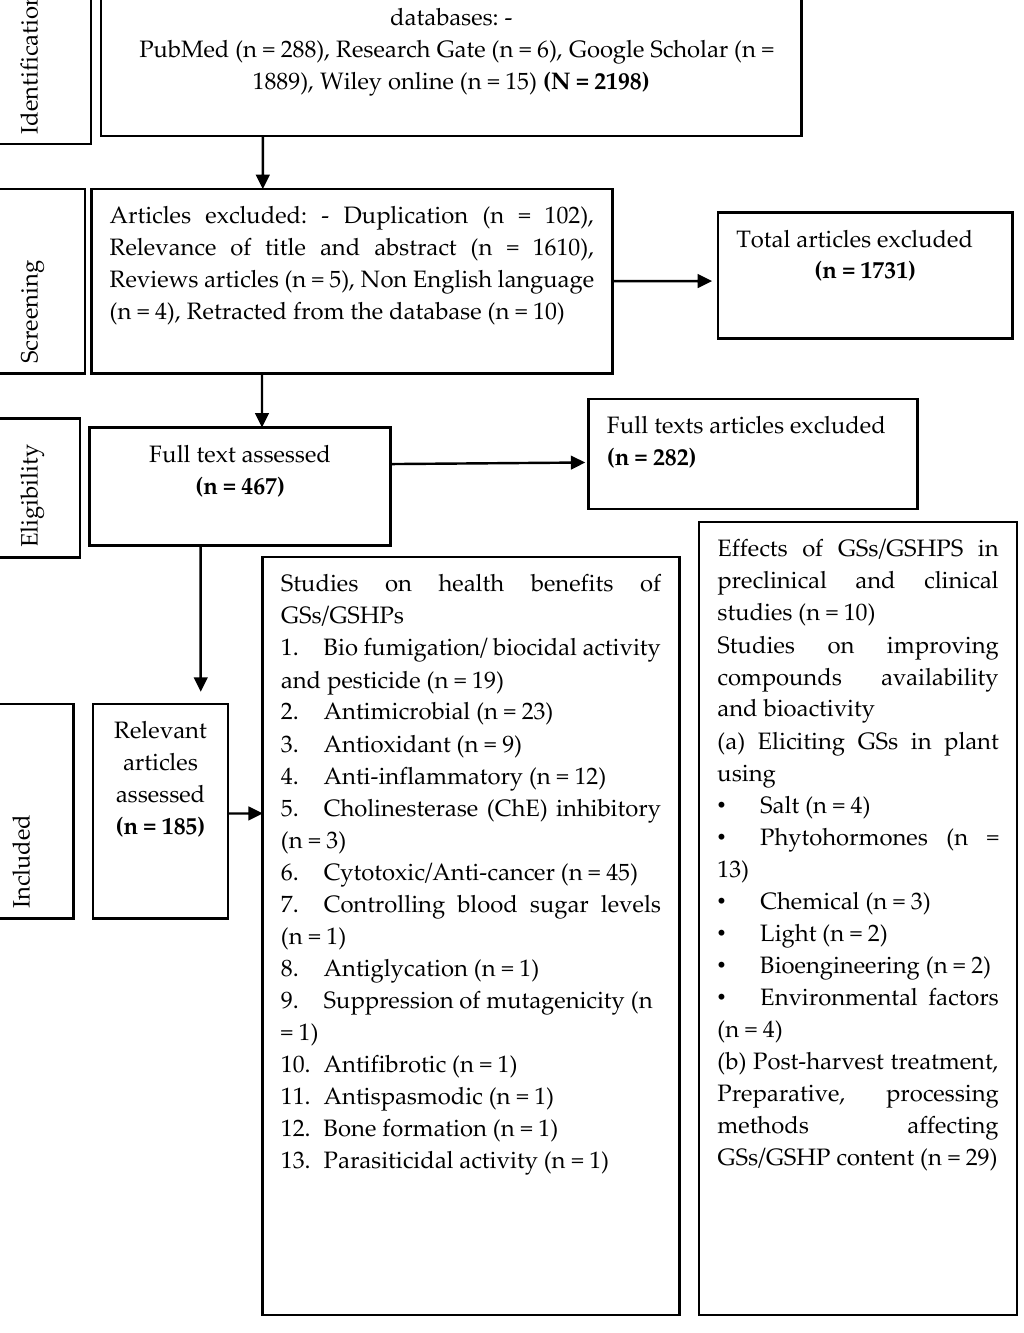
Figure 1. This figure shows the flowchart used in the article selection process.